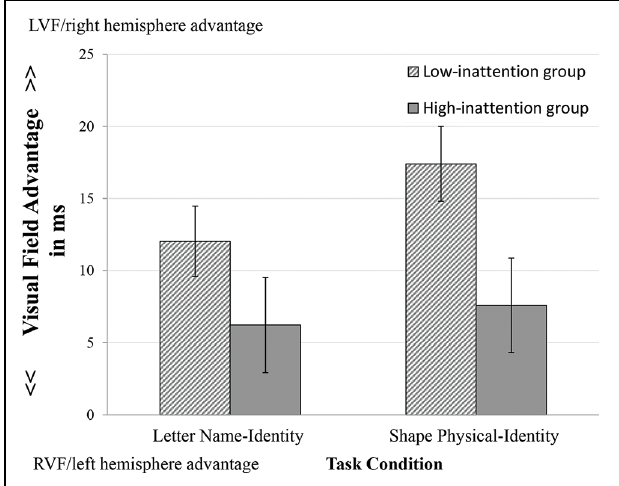
FIGURE 5 | Visual field advantage in the groups with High- and Low-score on inattention subscale. Error bars indicate standard